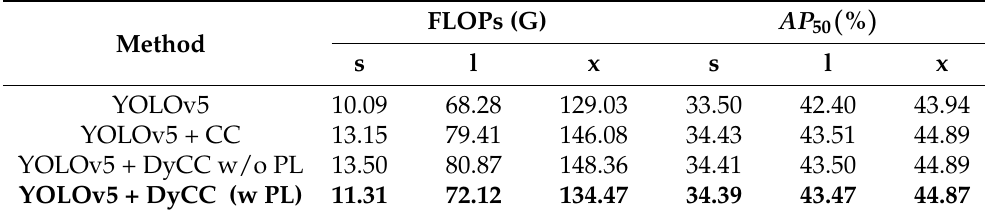
Table 2. Effectiveness of the proposed DyCC and Pseudo Learning (indicated as “PL”) on computa- tion cost (measured by “FLOPs (G)”) and detection accuracy (measured by “ AP 50 ”). The text ‘s’, ‘l’ and ‘x’ refer to small YOLOv5 (“YOLOv5-s”), medium YOLOv5 (“YOLOv5-l”), and large YOLOv5 (“YOLOv5-x”), respectively.